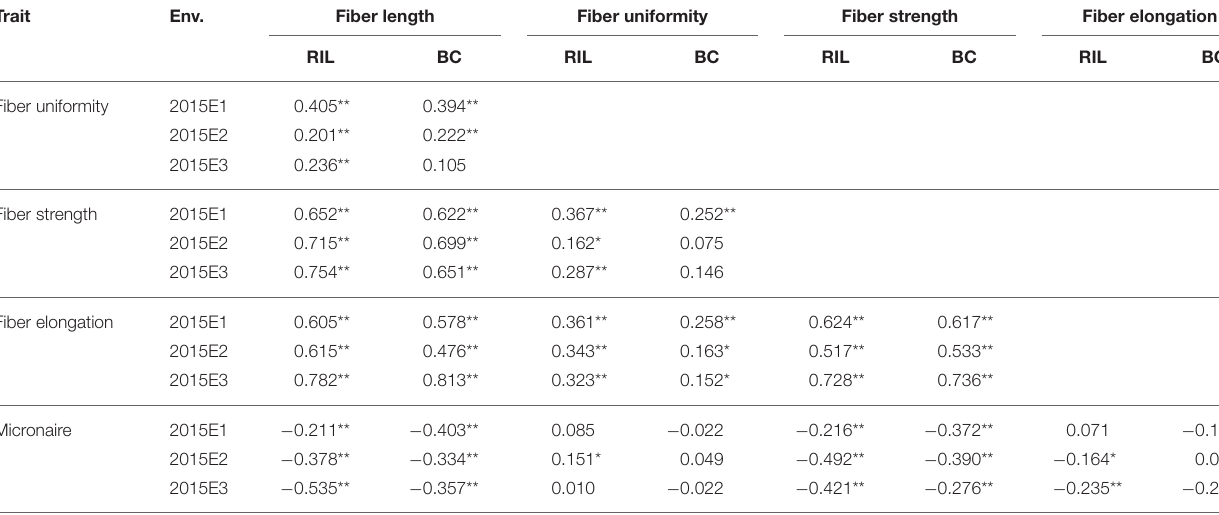
TABLE 3 | Correlation analysis between fiber quality traits in RIL population and its BC population. Trait